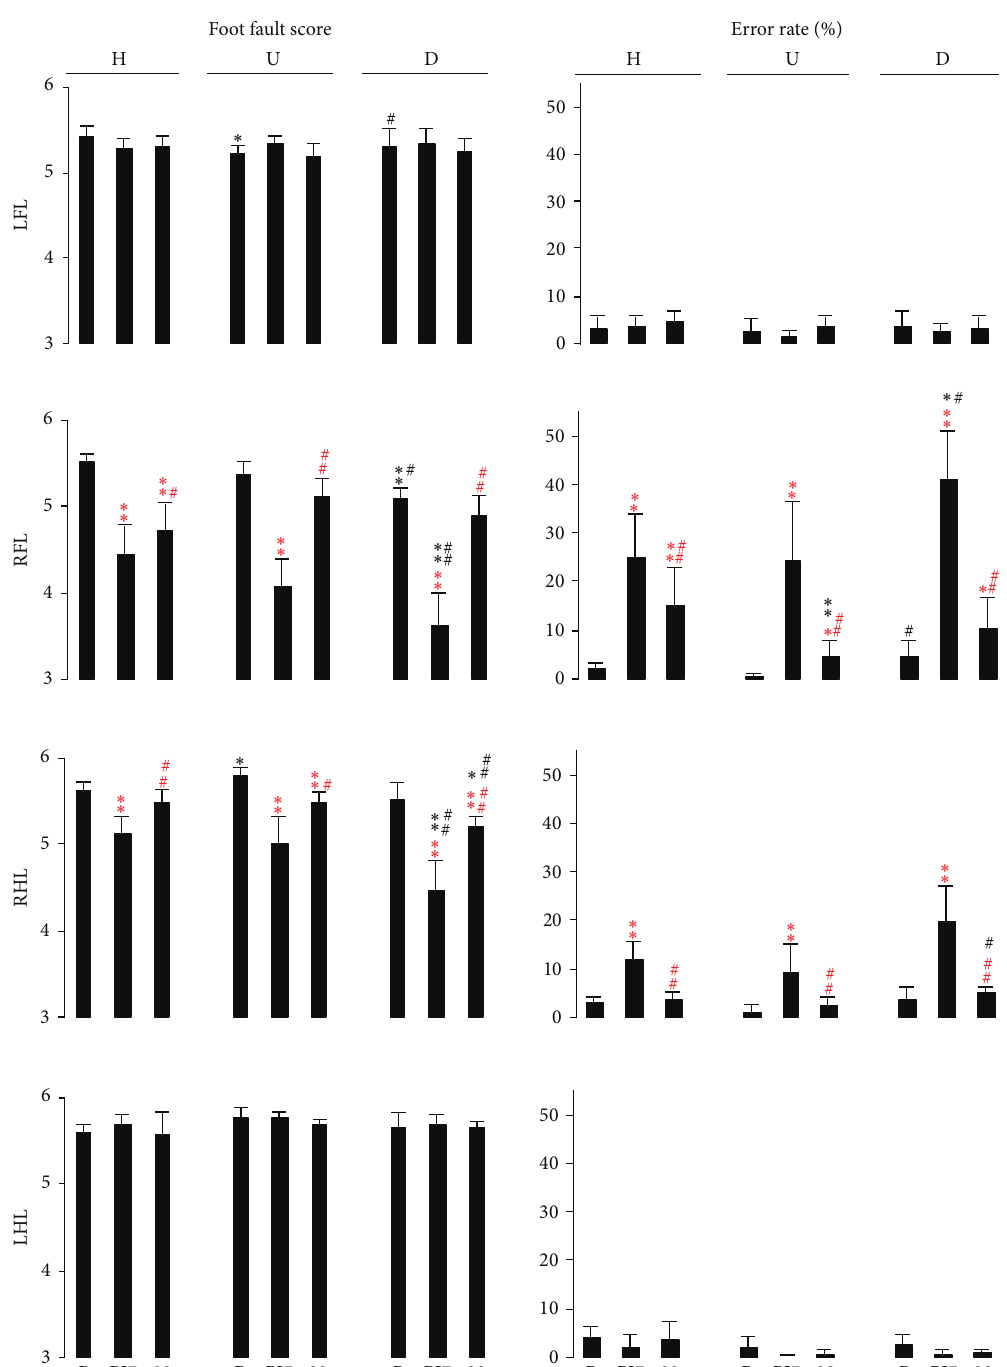
Figure 2: Limb placement and accuracy in inclined ladder rung walking. Horizontal (zero inclination), upward, and downward walking across the rung ladder were analyzed using qualitative ratings for limb placement and accuracy (foot fault score), and quantitative analysis (error rate in stepping), evaluated for each limb before and after focal photothrombotic lesion undertaken in the respective areas of the motor cortex of both right forelimb and hind limb. Lesion-related motor deficits of the hind limb were most sensitively detected in inclined walking. H: horizontal ladder, U: upward ladder, D: downward ladder, B: baseline, PI 7: postischemic day 7, PI 28: postischemic day 28, LFL: left forelimb, RFL: right forelimb, RHL: right hind limb, LHL: left hind limb. one red stars 𝑃 < 0.05 , two red stars 𝑃 < 0.01 versus baseline, red # 𝑃 < 0.05 , red ## 𝑃 < 0.01 versus PI 7; ∗ P < 0.05, ∗∗ P < 0.01 versus H, # P < 0.05, ## P < 0.01 versus